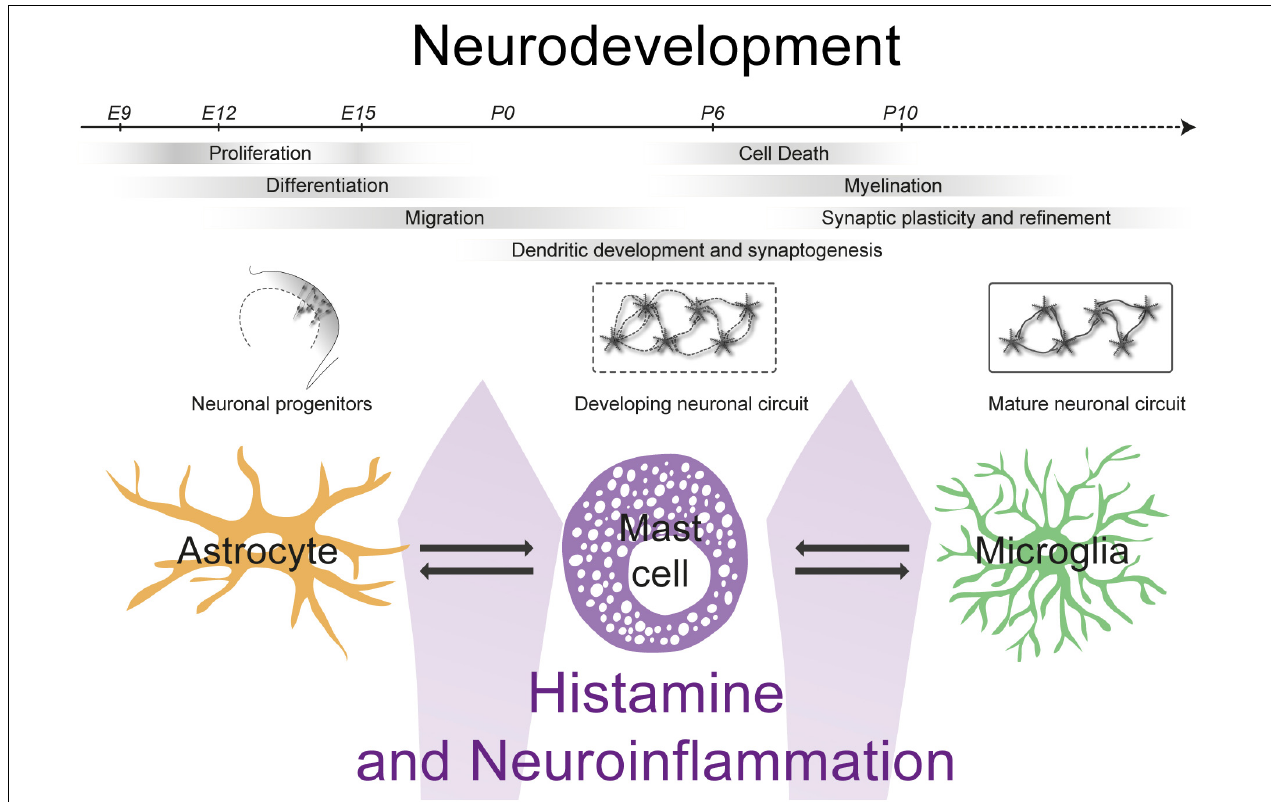
FIGURE 1 | The interactions between mast cells, astrocytes and microglia can impact levels of histamine and neuroinflammation influencing neurodevelopment.